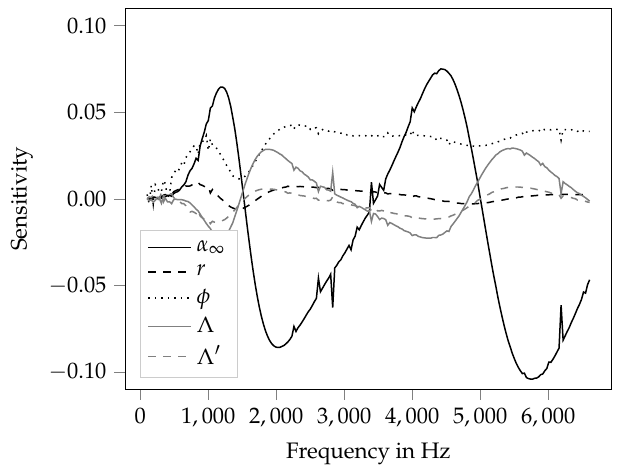
Figure 7. Frequency-dependent sensitivity coefficients of all input